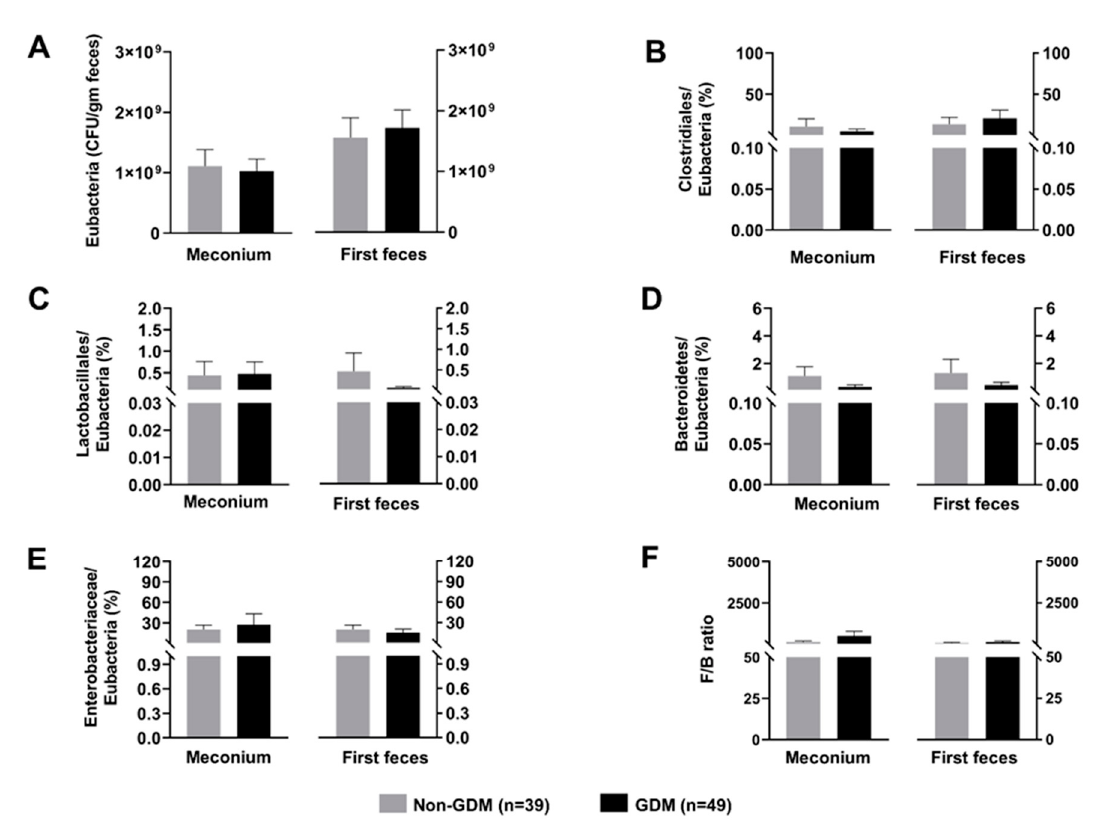
Figure 2. Composition of neonatal gut microbiota; ( A ): Total count of Eubacteria , ( B ): Normalized abundance of Clostridiales , ( C ): Normalized abundance of Lactobacillales , ( D ): Normalized abundance of Bacteroidetes, ( E ): Normalized abundance of Enterobacteriaceae , ( F ): F/B ratio. Data are reported as mean ± SEM. The Mann–Whitney U test was used to determine the difference between groups. GDM: Gestational diabetes mellitus; F/B ratio: Firmicutes/Bacteroidetes ratio.